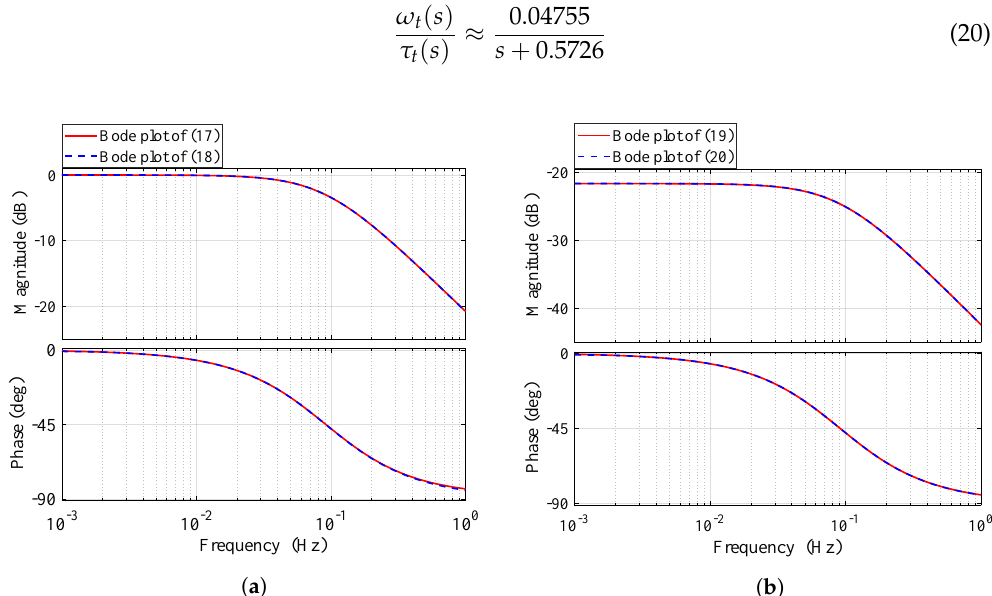
Figure 10. Bode plot of the transfer function for ( a ) the complete (mechanical and electrical) and ( b ) the mechanical part of the wind turbine